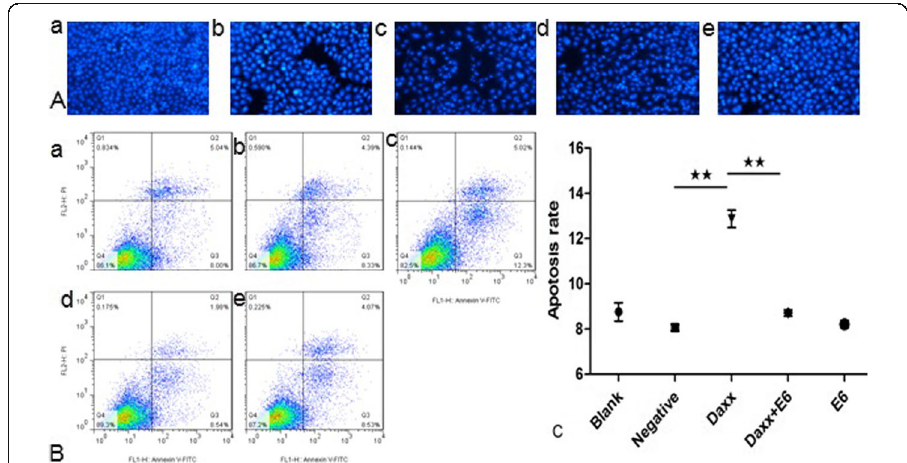
transfection; (b) C33A cells with empty vector transfection; (c) C33A cells with Daxx transfection; (d) C33A cells with E6 and Daxx co-transfection; (e) C33A cells with E6 transfection. B Representative flow cytometry data. (a) C33A cells without transfection; (b) C33A cells with empty vector transfection; (c) C33A cells with Daxx transfection; (d) C33A cells with E6 and Daxx co-transfection; (e) C33A cells with E6 transfection. C Apoptosis rate. The mean apoptosis rate of each group came from the flow cytometry data. ★★ , p <